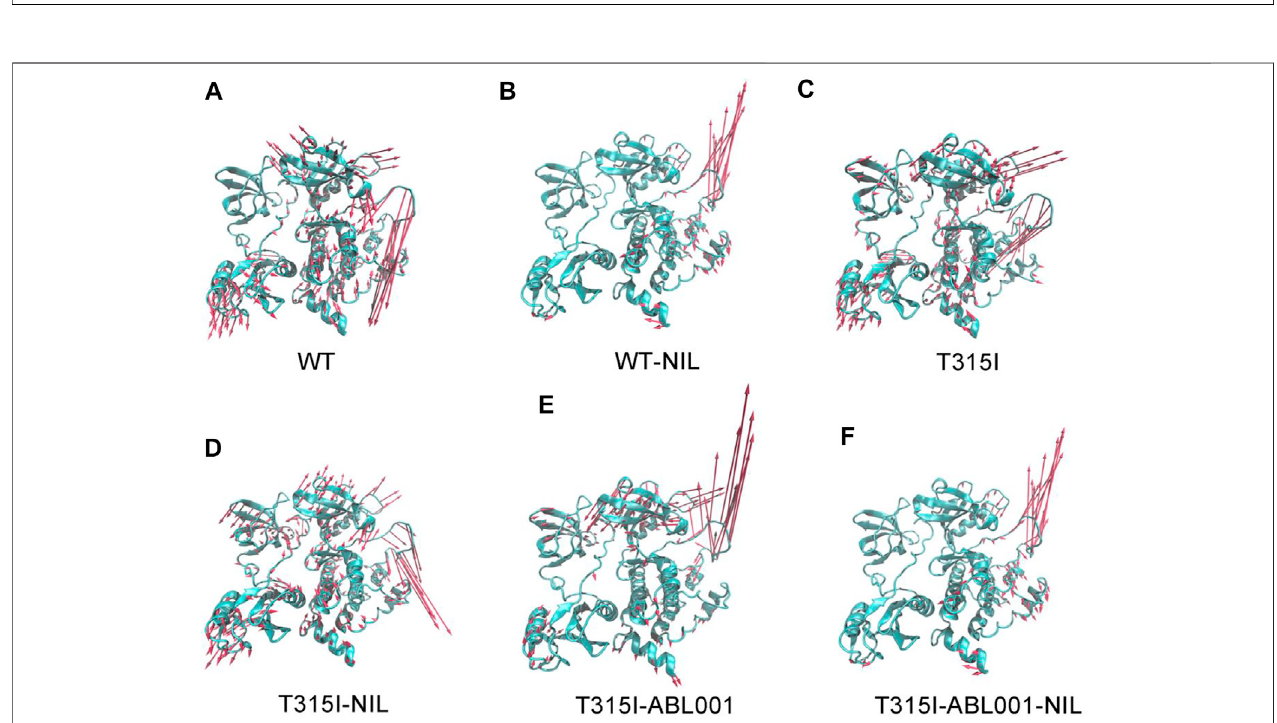
Frontiers in Pharmacology |